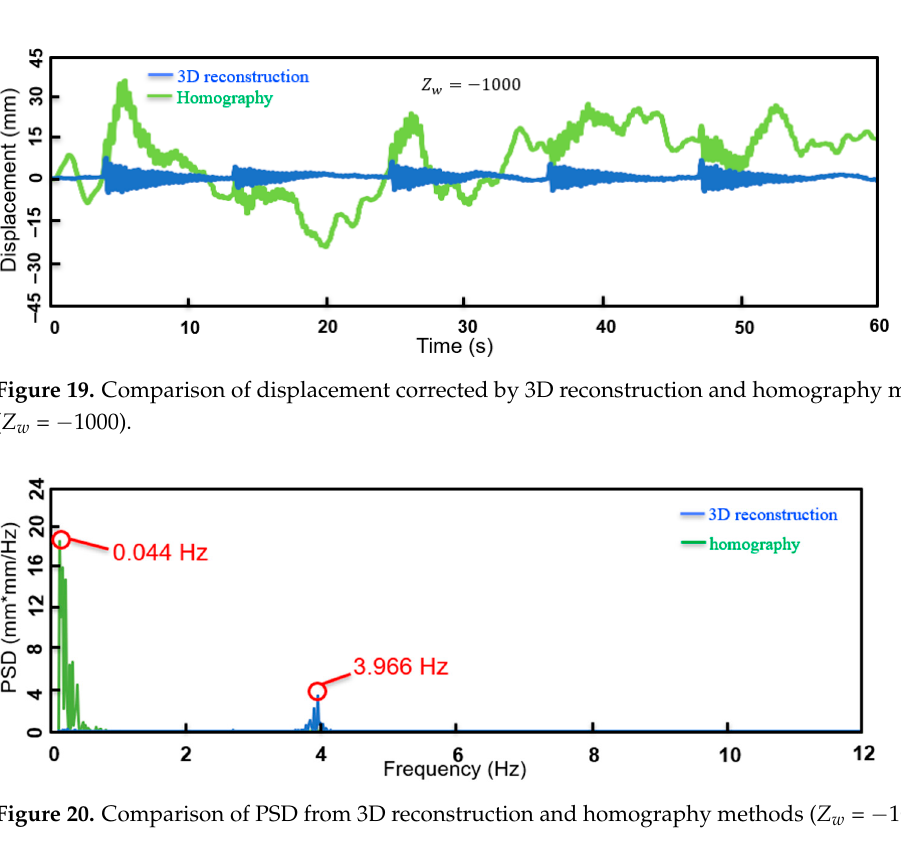
Figure 18. Six degrees of freedom motion of the UAV ( Z w = − 1000).